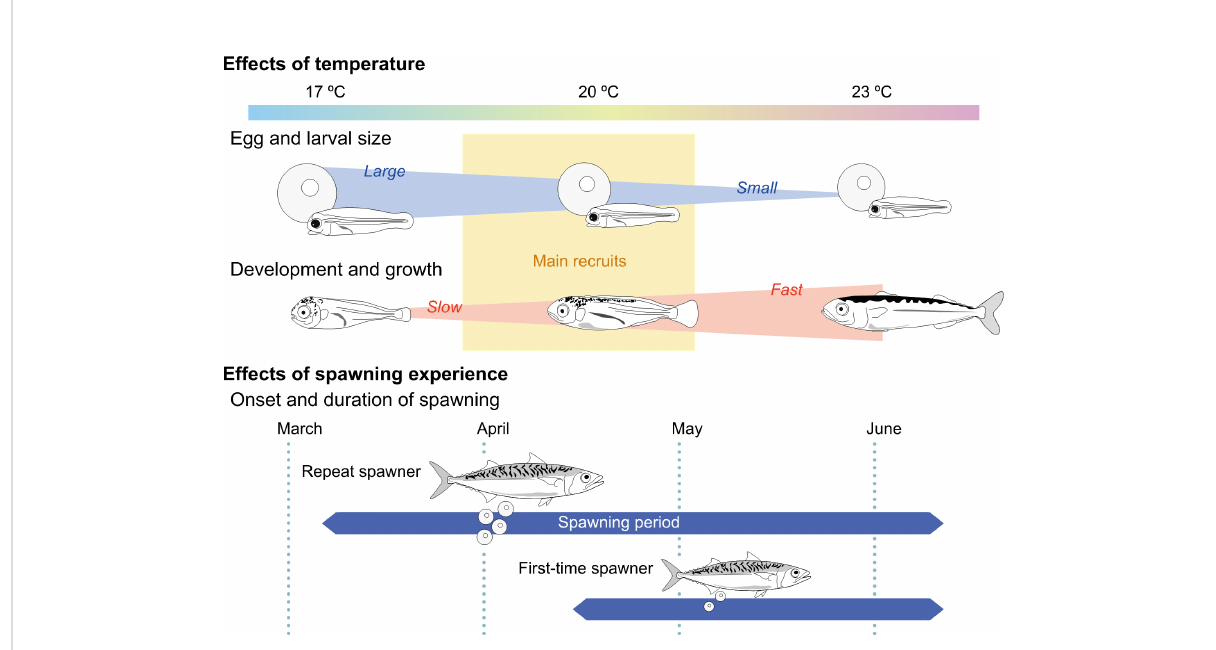
FIGURE 9 Schematic representation of the effects of temperature and spawning experience on life history traits of chub mackerel. The size of egg and larva at fi rst-feeding and ontogenetic development and growth were differently affected by temperature; the larval and egg size decrease with increasing temperature, while development and growth are advanced and faster in warmer waters. The estimated temperature of wild fi sh (main recruits) experienced until age 25 days ranged from 18.0 to 20.3°C. The onset timing and duration of spawning appeared to differ between repeat spawners and fi rst-time spawners (after Watanabe and Yatsu, 2006; Watanabe, 2010); the repeat spawners start spawning earlier and longer than the fi rst-time spawners. Larvae derived from repeat spawners were larger on the day of fi rst-feeding and grew faster than those from fi rst-time spawners at identical